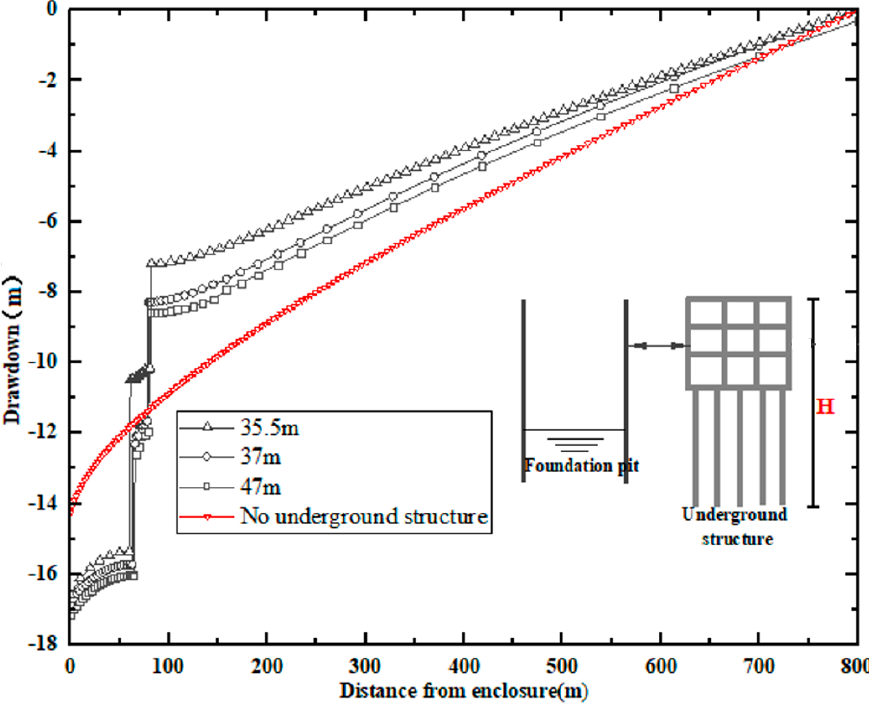
Figure 7. Distribution of groundwater drawdown under different H .